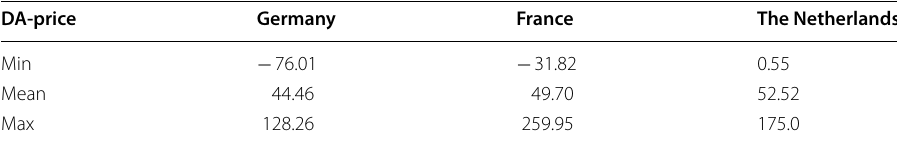
Table 7 Day-ahead price of 2018 in Germany, France, and The Netherlands: minimum, mean, and maximum values in €